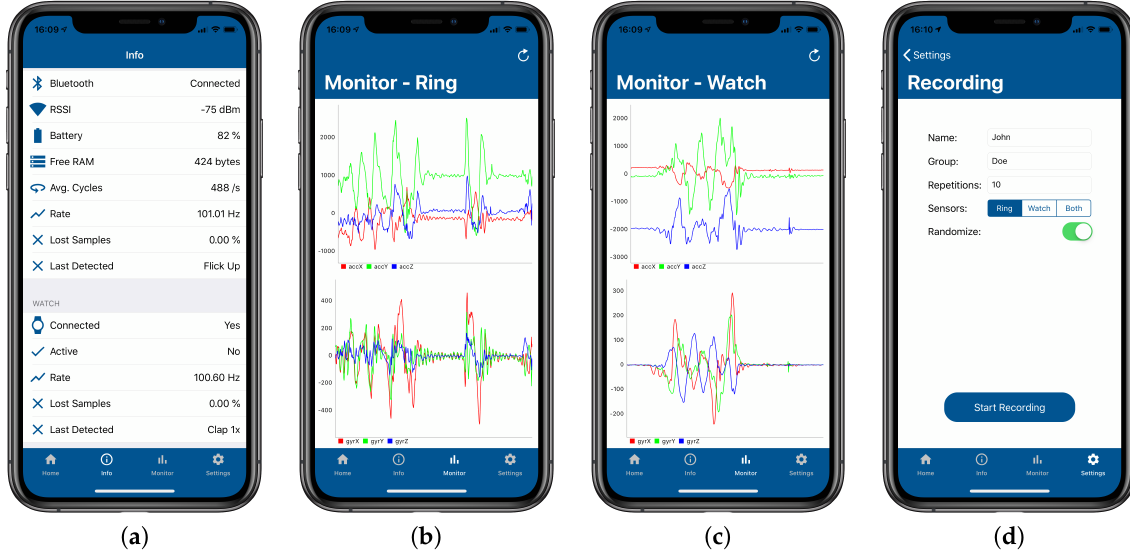
Figure 3. Info screen ( a ), ring monitor screen ( b ), the watch monitor screen ( c ) and the recording screen ( d